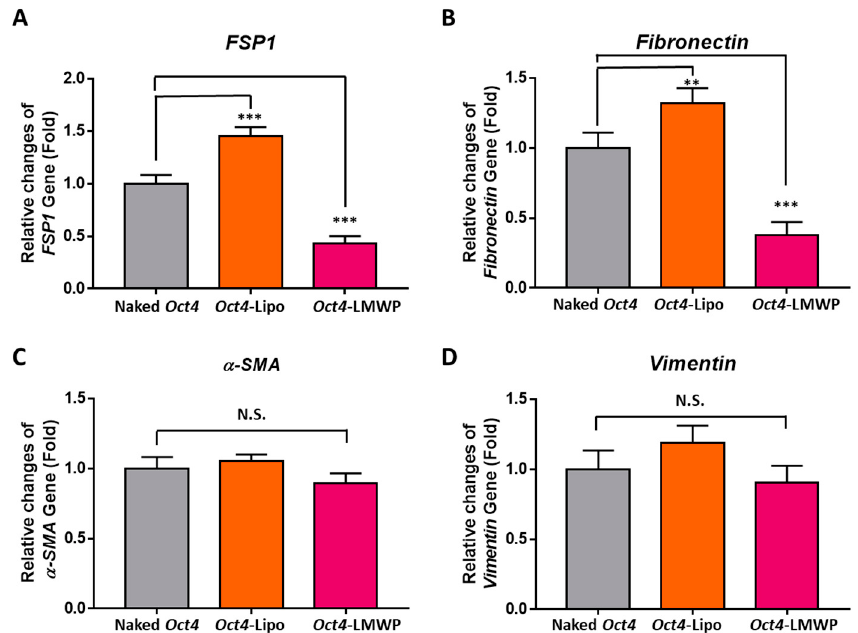
Figure 6. Gene expression of fibroblast-specific markers in MEF cells. Changes in the expression of fibroblast-specific marker genes ( A ) FSP1 , ( B ) fibronectin , ( C ) a-SMA , and ( D ) vimentin in MEF cells with Oct4 delivered by lipofectamine or Oct4-LMWP complex were confirmed by quantitative RT- PCR. The bar graph represents the relative fold changes in gene expression, which were determined by the cT value of each sample normalized to that of β -actin . Statistical significance between groups was analyzed using the Student’s t -test. The level of significance is represented as ** p < 0.001, *** p <